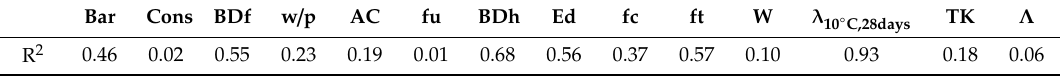
Table 10. Coe ffi cient of determination considering the dependent variable λ 10 ◦